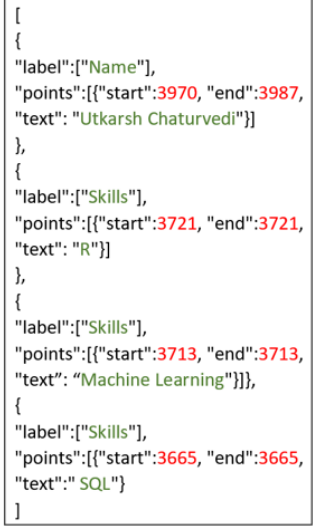
Figure 7. User profiles data